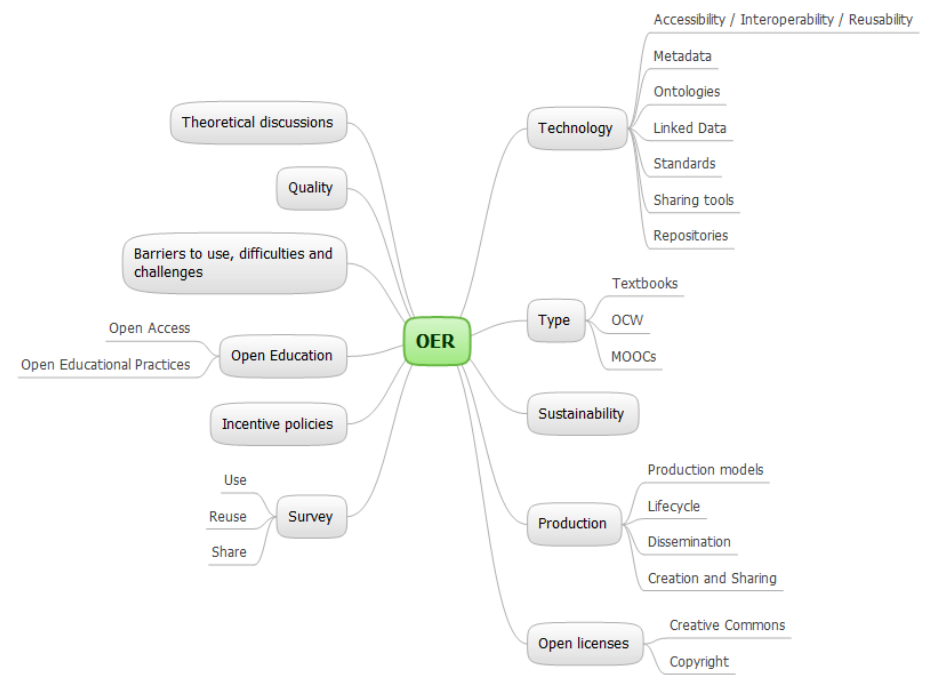
Figure 5. Macro-themes addressed by the